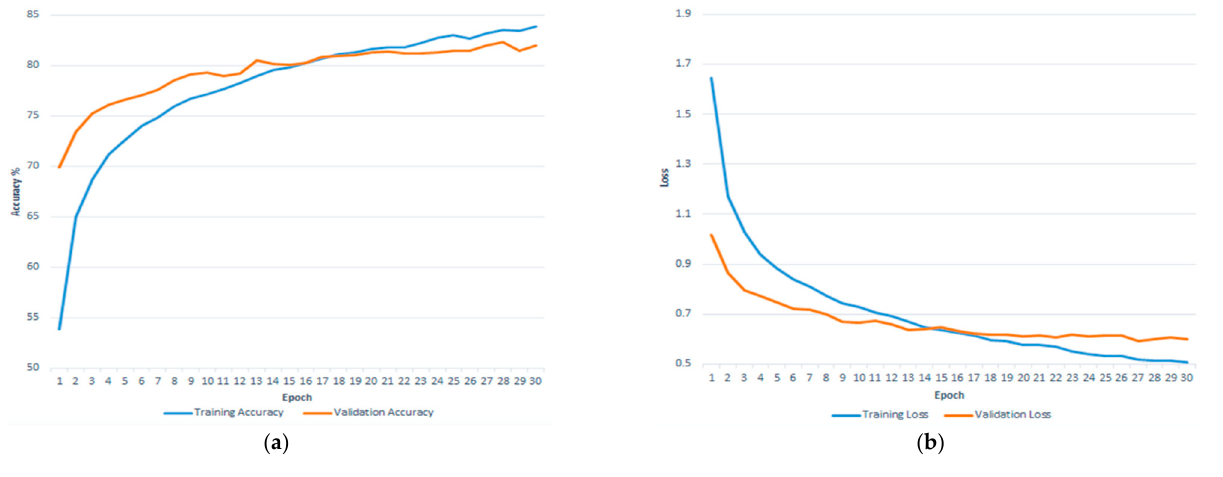
Figure 6. Recognition accuracy of VGG-16. ( a ) Training and testing accuracy; ( b ) training and validation loss in VGG-16 using PlantVillage dataset.